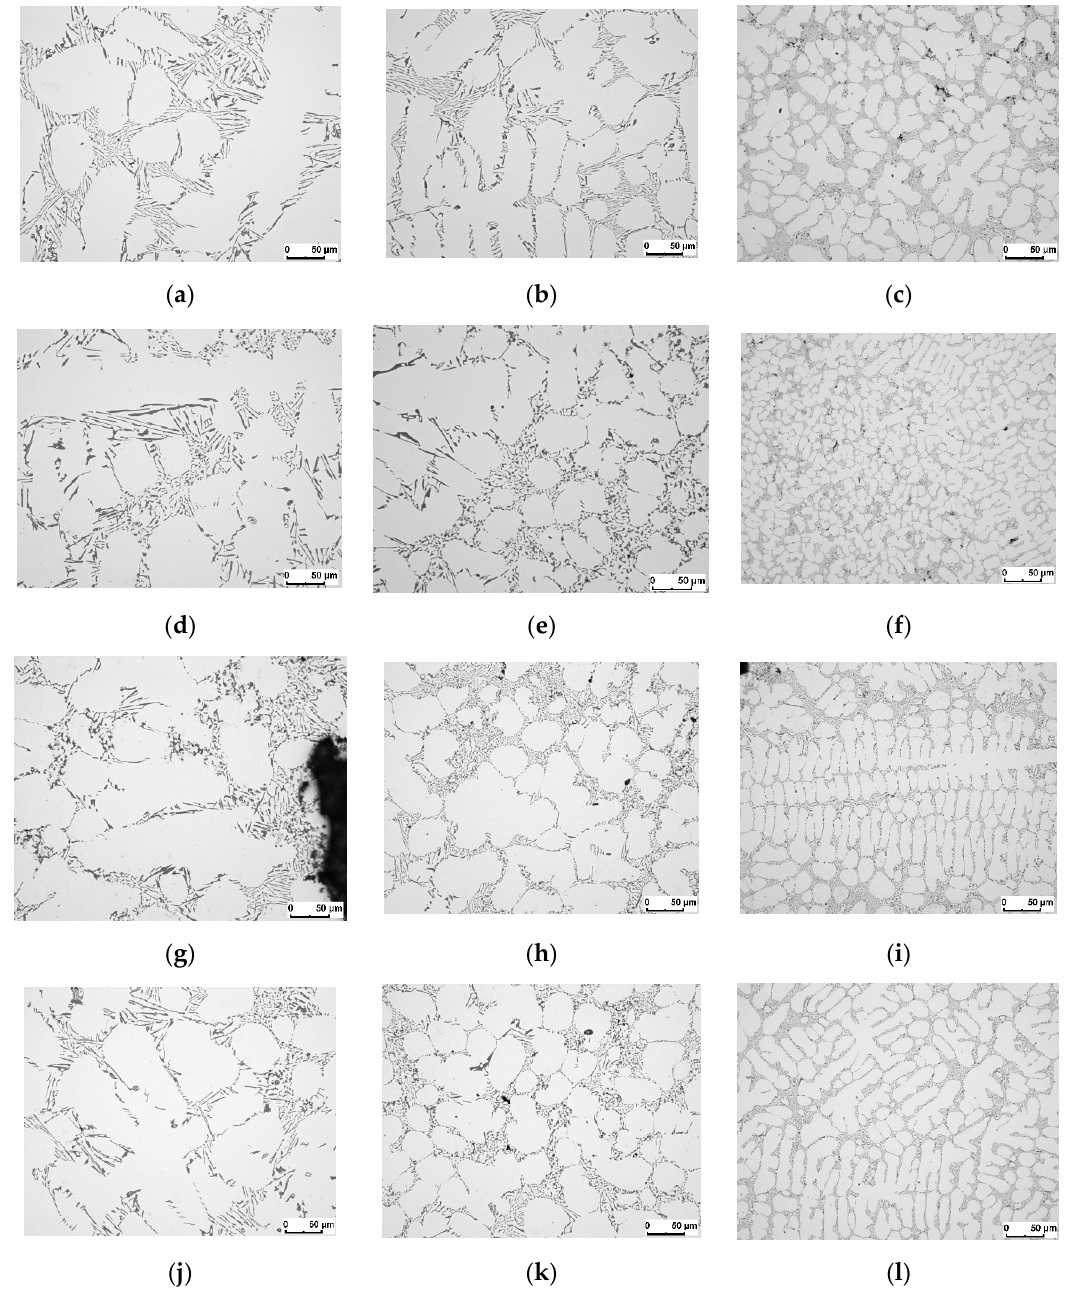
Figure 5. Powder compacts, morphology of the eutectic phase, influence of cooling rate and additives. Columns from left to right correspond to ( a , d , g , j ) natural convection, ( b , e , h , k ) forced convection and ( c , f , i , l ) water quenching, lines from top to bottom showing ( a – c ) reference samples without additives, followed by ( d – f ) 250 ppm Sr, ( g – i ) 350 ppm TiB 2 and ( j – l ) 140 ppm B. All images taken at identical magnification.